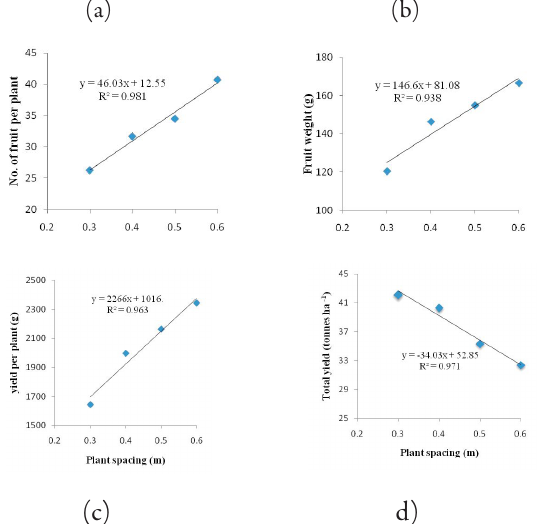
Fig. 4. Relationship between plant spacing and number of fruit per plant (a), fruit weight (b), yield per plant (c) and total yield (d)